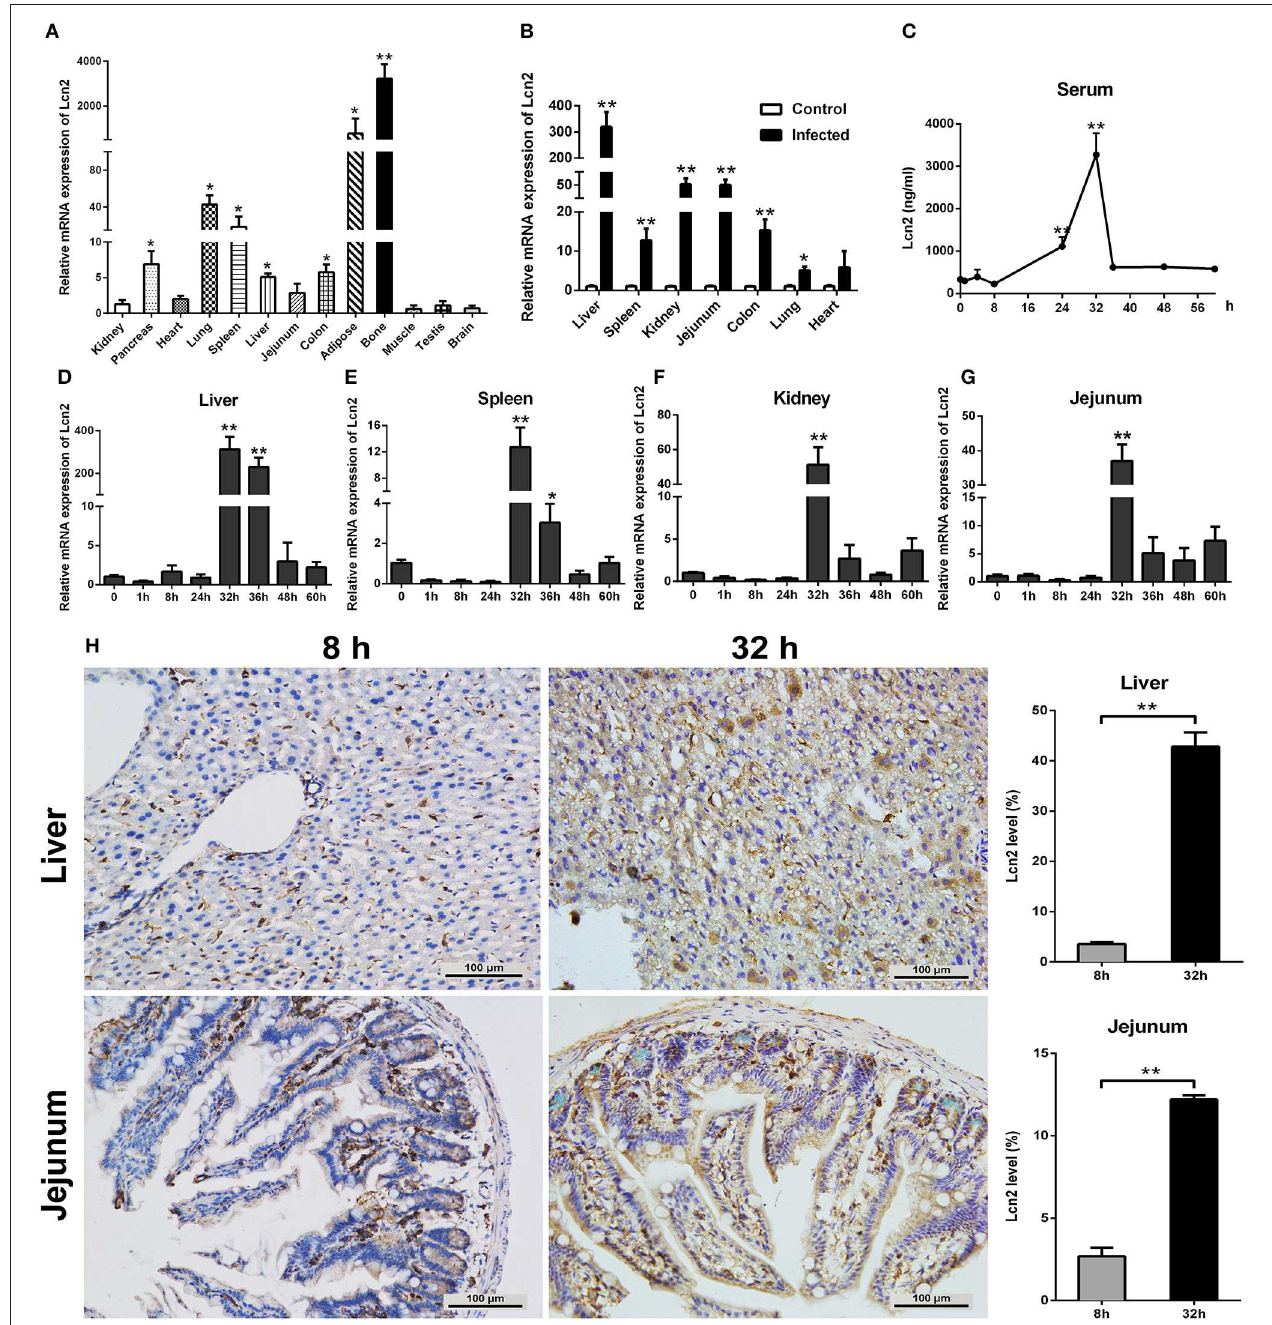
FIGURE 1 | Elevated lipocalin 2 (Lcn2) during E. coli O157:H7 infection. (A) Real-time PCR analysis of the levels of Lcn2 mRNA expression in indicated tissues of mice. (B) The mRNA levels of Lcn2 expression in indicated tissues of control and E. coli O157:H7-infected mice. (C) Serum levels of Lcn2 protein concentration in E. coli O157:H7-infected mice after challenge at different time points. (D–G) The mRNA expression levels of Lcn2 in indicated tissues from E. coli O157:H7-infected mice after challenge at different time points. (H) Protein levels of Lcn2 in mice detected on immunohistochemistry sections of liver and jejunum at 8 and 32h after challenge with E. coli O157:H7. Original magnification was 200 × . Values are average means of triplicate experiments. Error bars depict SEM ( n = 4 per time point). Results are expressed as means ± SEM. * P < 0.05, and ** P < 0.01.